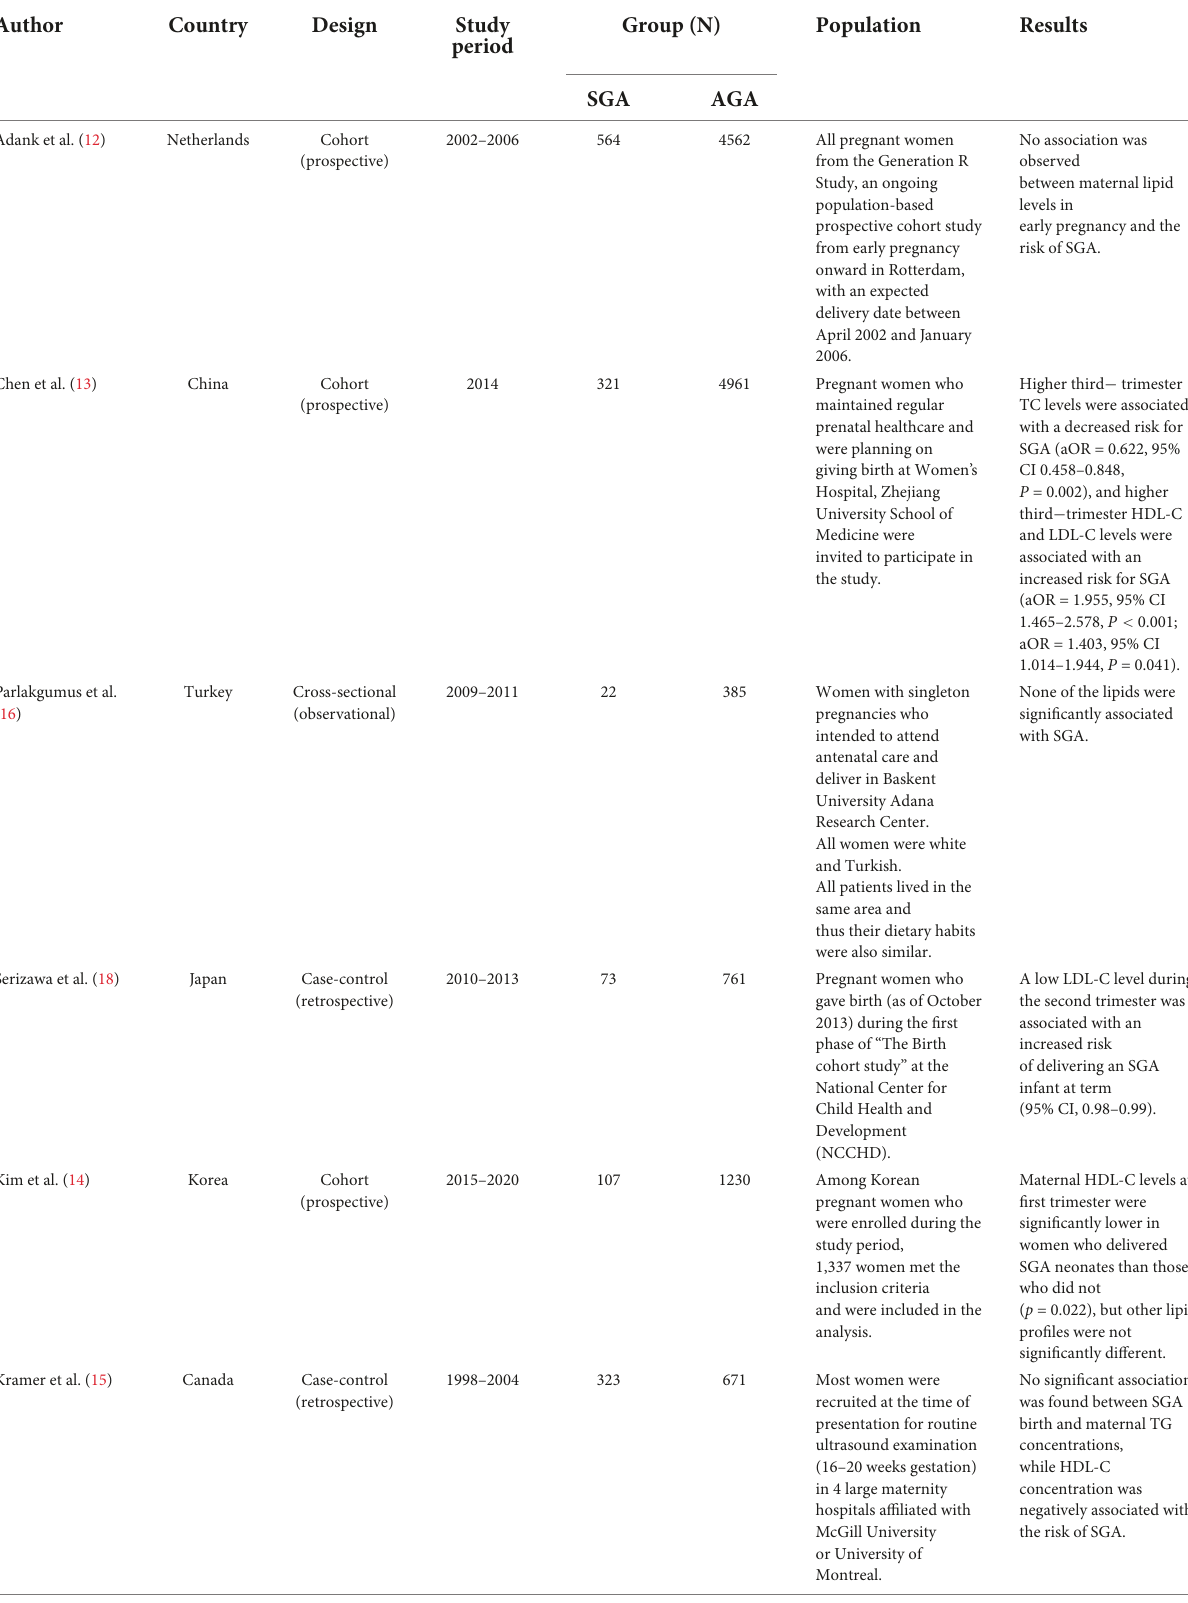
TABLE 1 General characteristics of the studies included in the